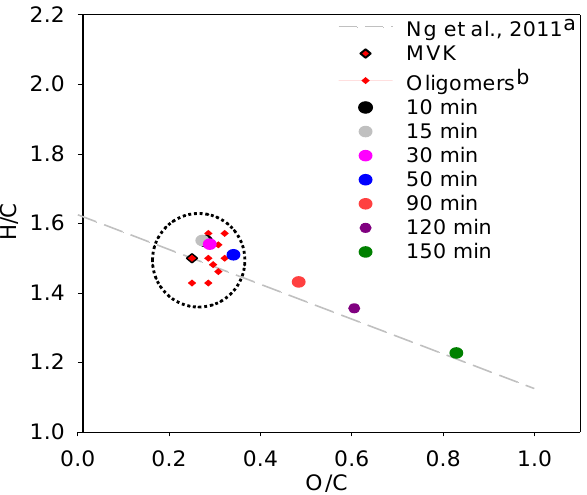
Figure 9. Van Krevelen diagram for the nebulized solutions of ex- periment C, as measured by the AMS. Only experiment C is shown for clarity as the data for experiments A and B are stacked together with the data shown. (a) Ng et al., 2011, for details see text Sect. 4.2. (b) Red diamonds represent the elemental ratios of oligomers with a degree of polymerization=5 for the 10 most abundant oligomer series identified by Renard et al. (2013). The black dotted circle highlights compounds with similar structures.